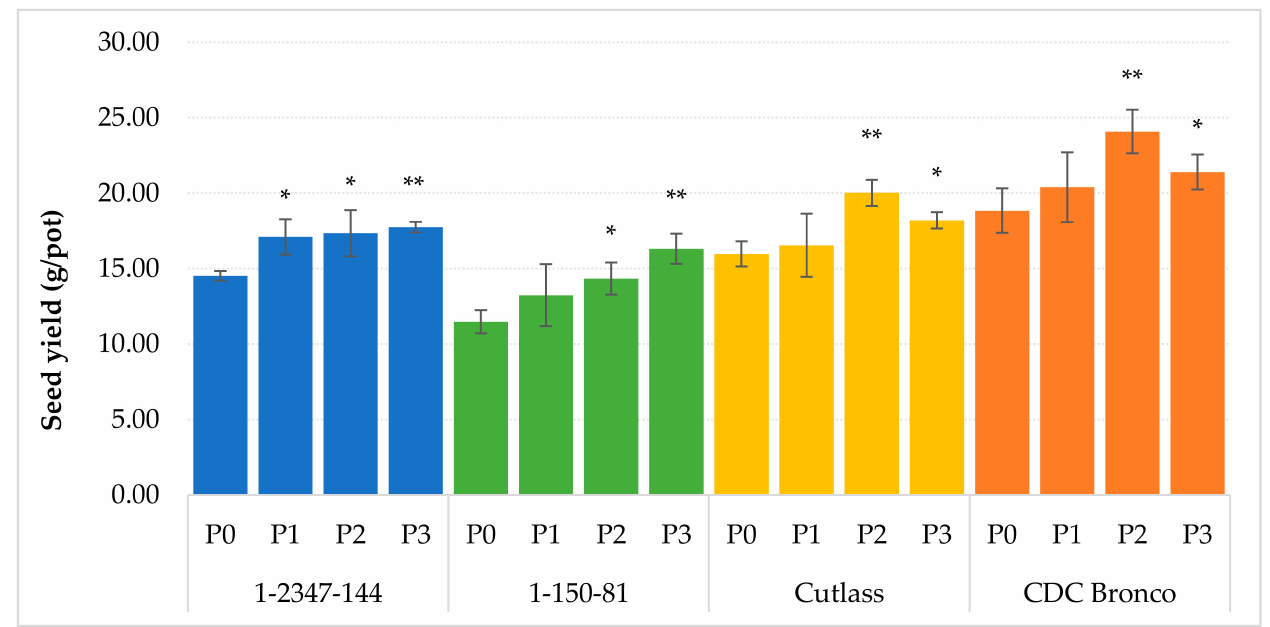
Figure 1. The effect of the foliar phosphorus application on the seed yield. The mean values ( n = 8) marked with an asterisk are significantly different (* p ≤ 0.05; ** p ≤ 0.01) from the variant without the P fertilization (P0) by the Fisher’s LSD test (each of the genotypes was statistically evaluated separately). Error bars represent the standard deviation of arithmetical mean